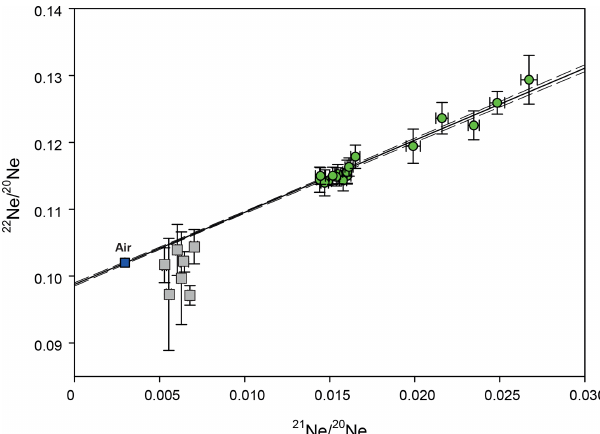
Figure 5. Neon three-isotope plot for CREU-1 intercomparison material measured in Cologne. Error bars are ± 1 σ . The cloud of green symbols displays single-step CREU extractions (100W– 15min), the green dots to the right of the cluster are the initial heat- ing (first extraction of a sample) steps of stepwise extractions (at varying laser output), grey rectangles are the subsequent steps that invariably had low abundance; for details see Table 1. Data of sam- ples depicted in green are included in the regression calculation; data of the grey rectangles are excluded. The slope of the regression of the data (forced through air) is 1.078 ± 0.022 ( ± 2 σ ), which is indistinguishable from the published value of 1.108 ± 0.014 ( ± 2 σ ; Vermeesch et al., 2015). The dotted line denotes the 95% confi- dence